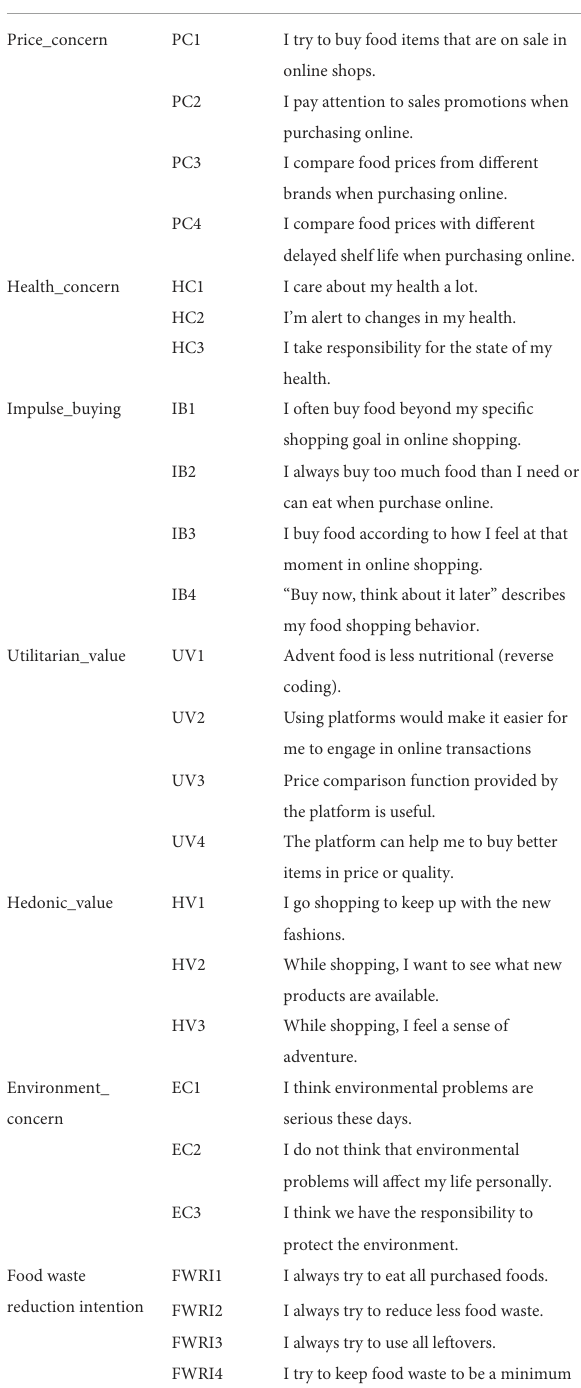
TABLE 1 Measurement of